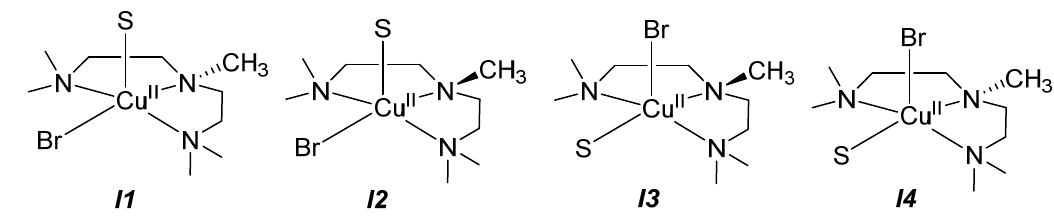
Figure 2. Possible isomers of [Cu II (PMDETA)Br(S)] + , with S = MeCN or DMSO. Four [Cu II (PMDETA)Br(S)] + isomers (denoted as In with n = 1, 2, 3, 4) were studied to Table 5. ∆ G r (kcal/mol) of the coordination reaction of [Cu II (PMDETA)Br] + with a solvent molecule calculated in gas phase and in implicit solvent; level of theory: (PCM-)M06/6-311+G(d,p).